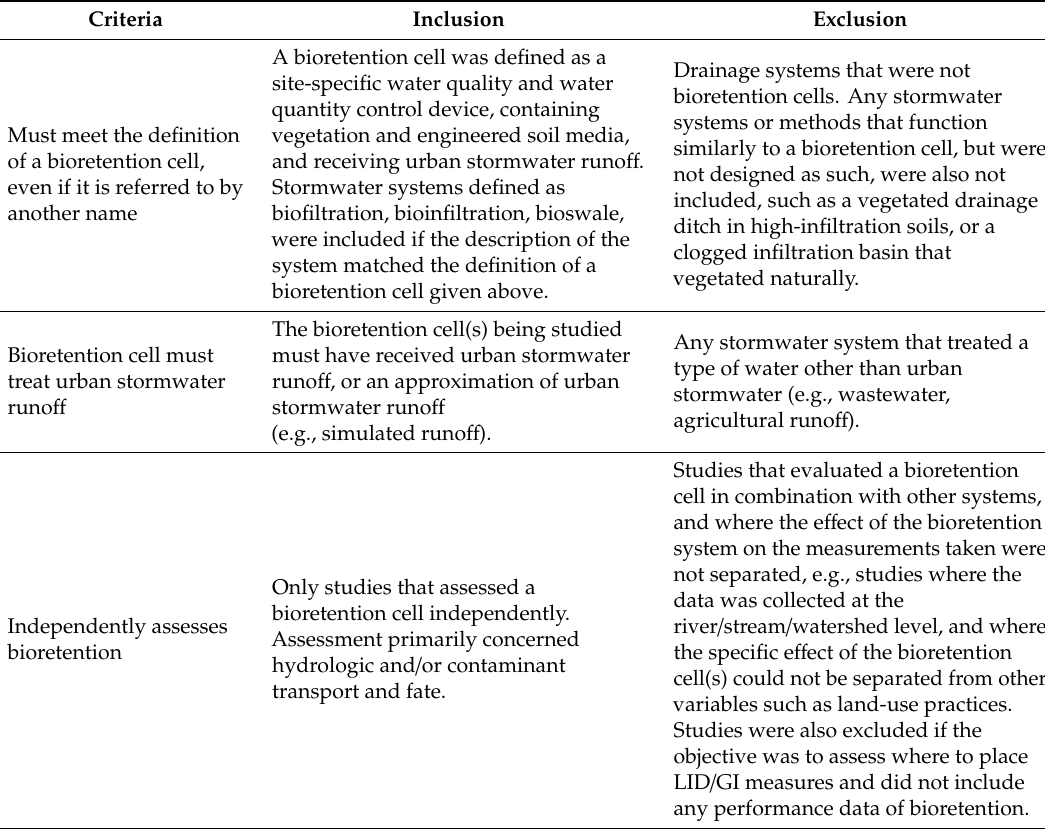
Table 1. Scoping Review Inclusion and Exclusion